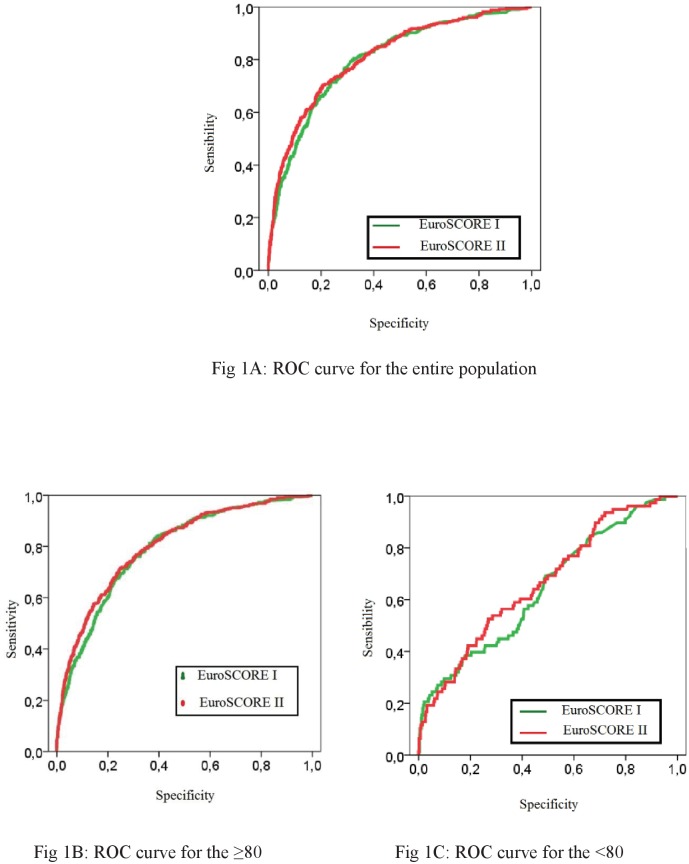
Receiver operating characteristics curves for the two models, for the entire population (Fig 1A) and for the two studied groups (Fig 1B: ≥80 and Fig 1C: <80).